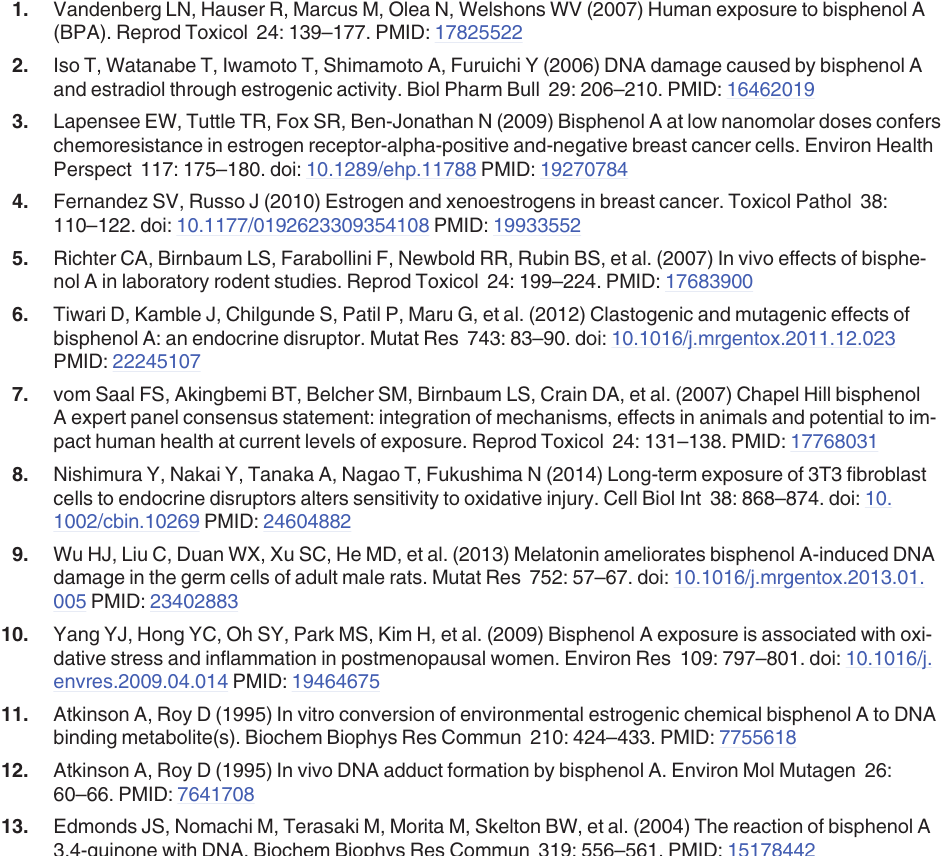
S2 Fig. Strand break signaling by γ H2AX in Ogg1 — proficient and — deficient cells. γ H2AX foci were measured at 4 h after exposure to BPA alone, KBrO (see Material and Methods). Each bar represents mean ± SEM of three independent experiments. S1 Table. Levels of modified DNA bases in genomic DNA in Ku70 +/+